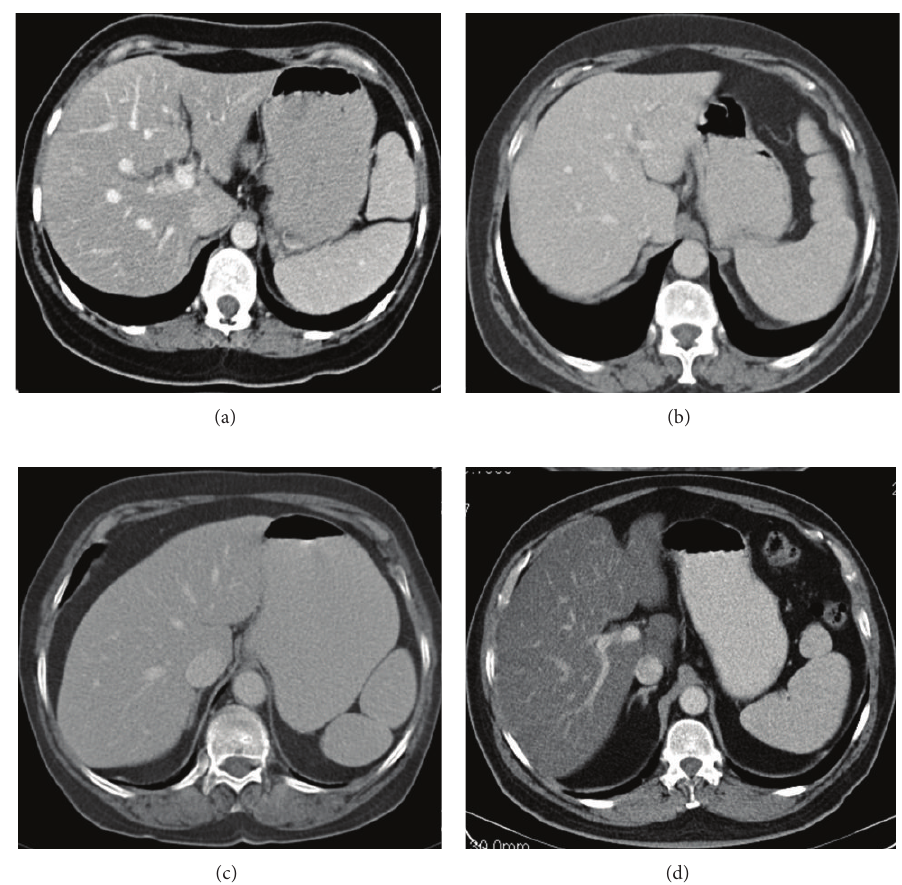
Figure 2: Axial contrast enhanced CT images show examples of splenic clefts in four different patients which were incidentally detected. In (b) there are also coexisting fetal lobules at the medial aspect of the spleen.